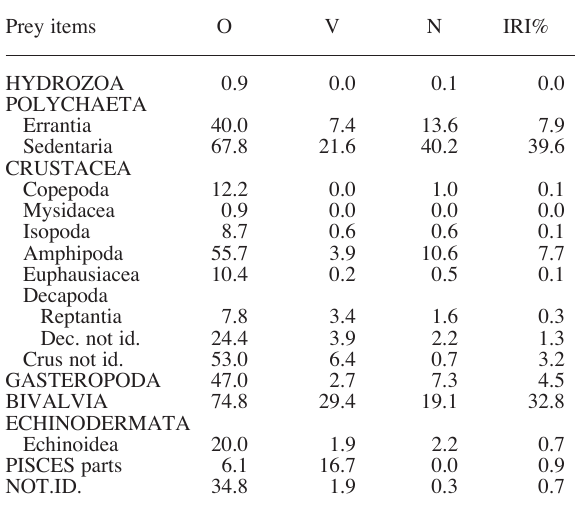
T ABLE 5. – Diet composition of L. mormyrus in the Thracian Sea coastal area expressed as frequency of occurrence (O), volume per- centage (V), percentage by number (N) and the percentage of the index of relative importance ( IRI % ). Prey items